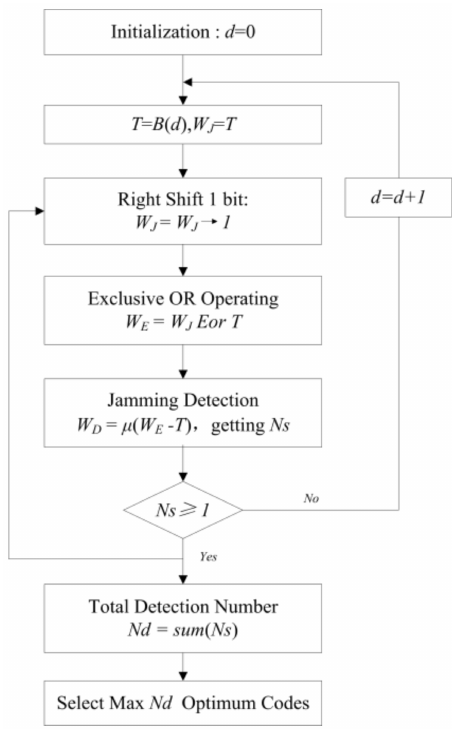
Figure 4. Encoding method flowchart.